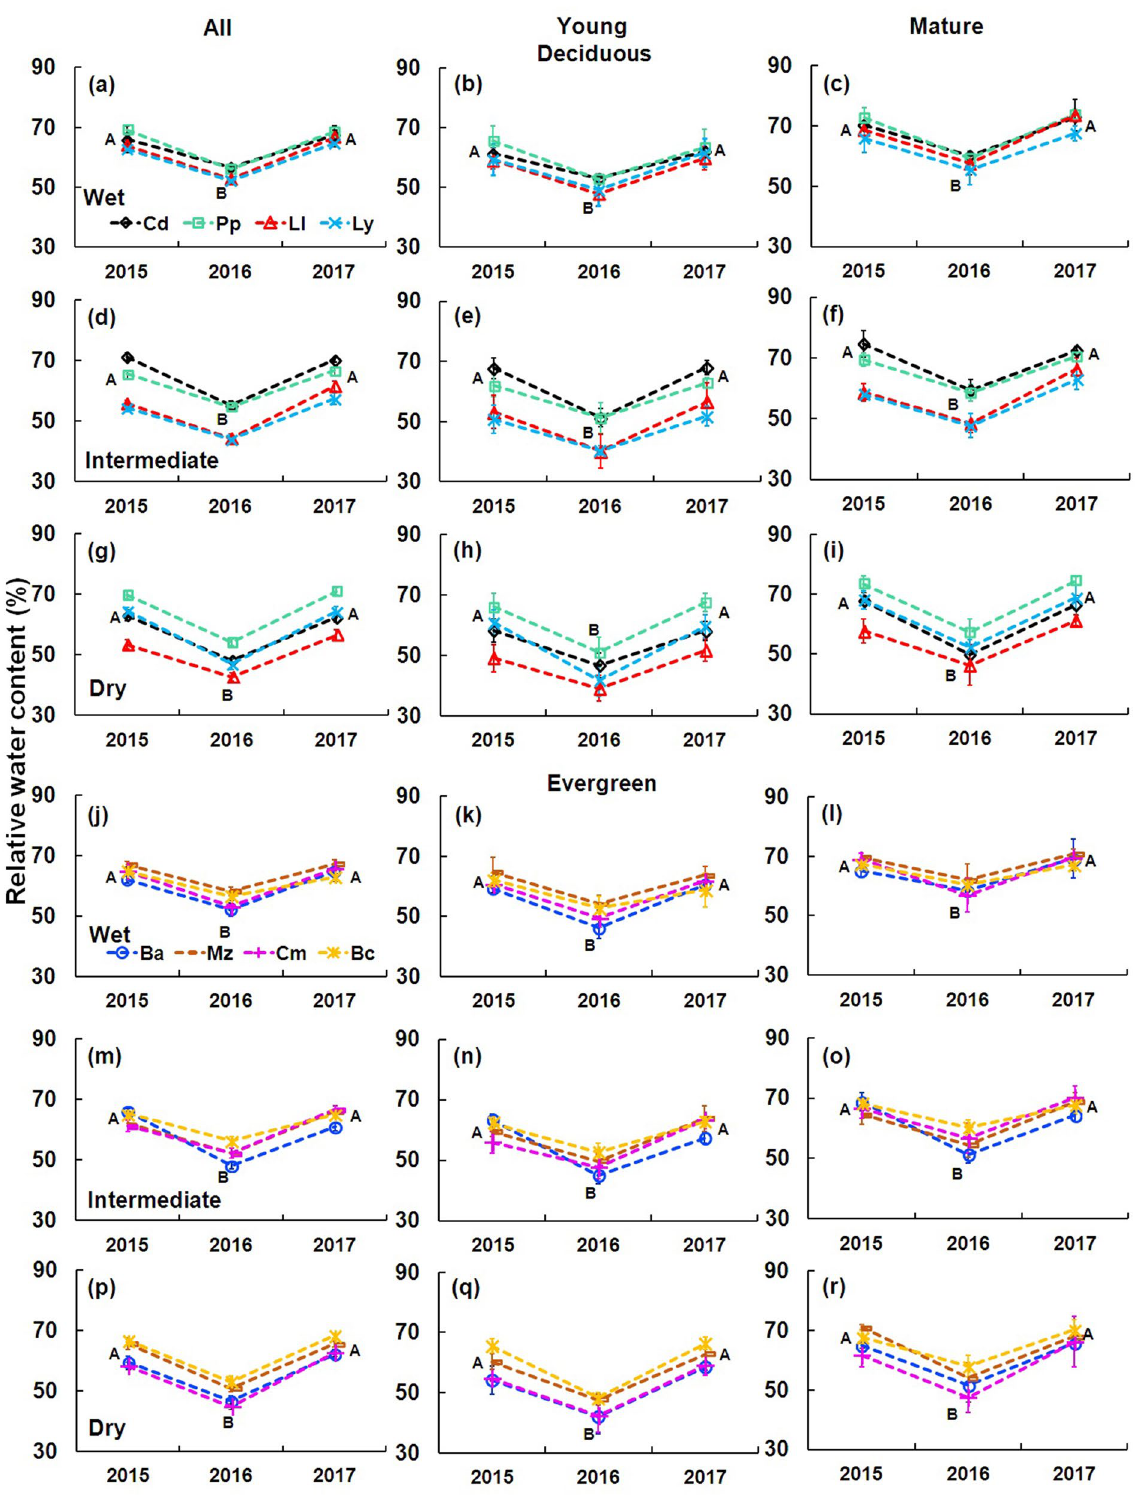
Figure 3. Relative water content of studied species in all sites from 2015 to 2017. Deciduous species ( a – i ): Cordia dodecandra (Cd), Piscidia piscipula (Pp), Leucaena leucocephala (Ll), Lysiloma latisiliquum (Ly). Evergreen species ( j – r ): Brosimum alicastrum (Ba), Manilkara zapota (Mz), Chrysophyllum mexicanum (Cm), Byrsonima crassifolia (Bc). Data are means ± SE. Capital letters next to the species indicate significant differences among